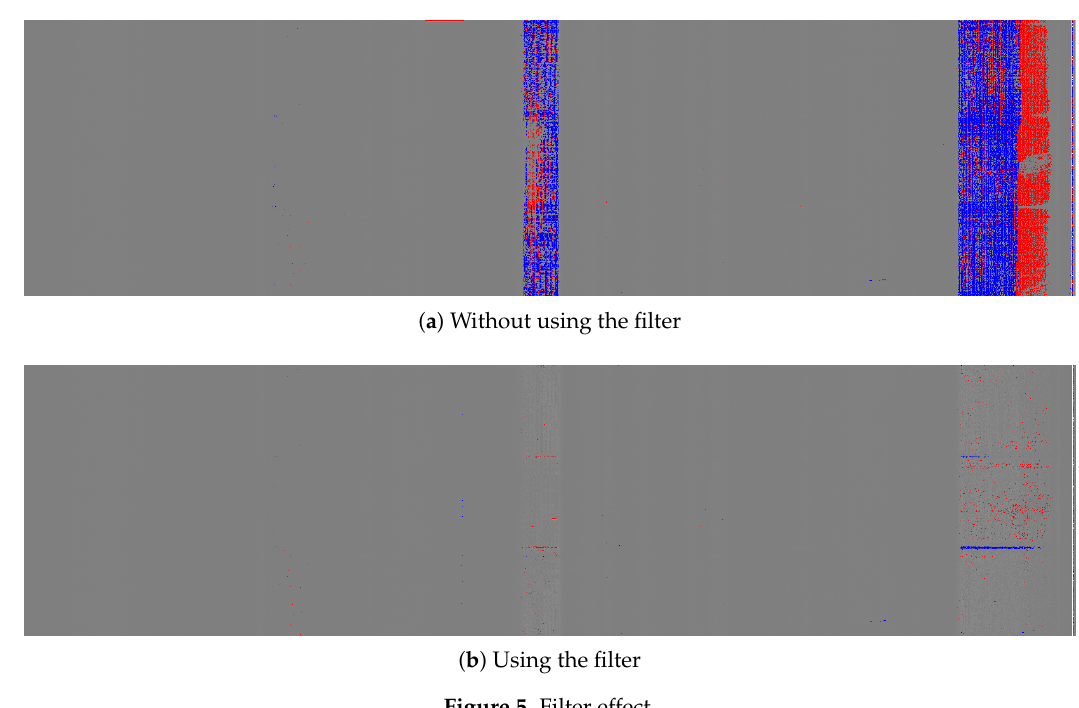
Figure 5. Filter